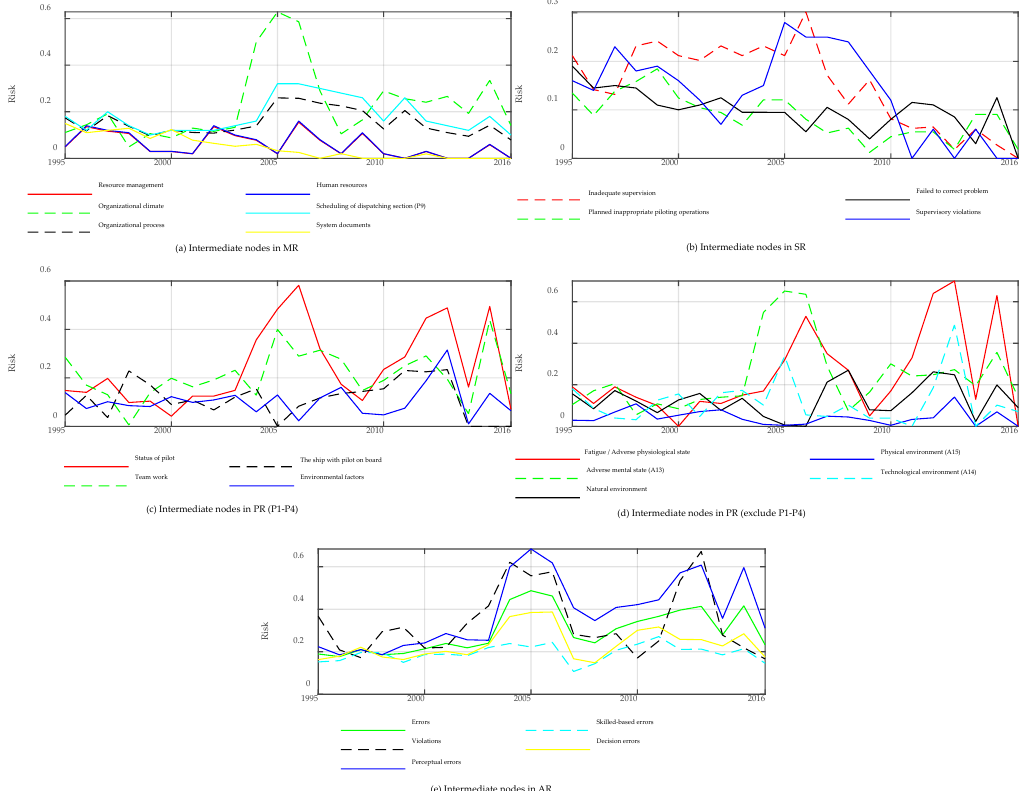
Figure 8. The risk of 28 intermediate nodes (including four overlapping intermediate nodes (INs)) from 1995 to 2016.